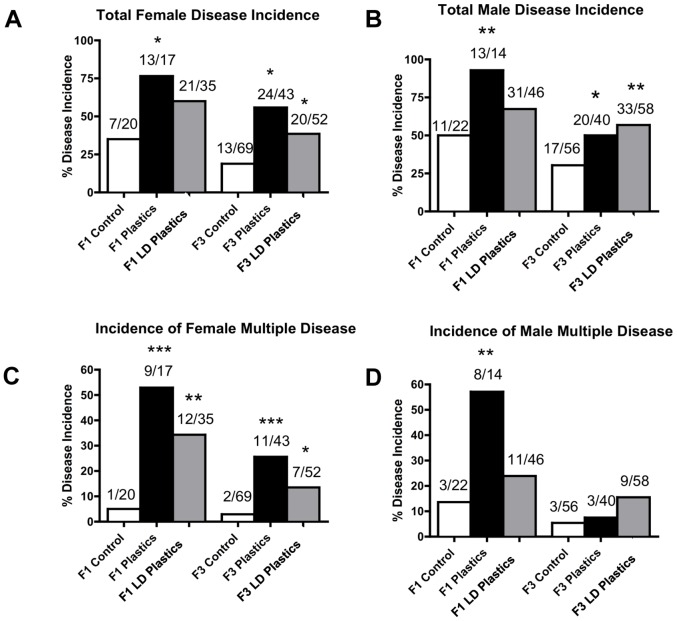
Adult-onset disease/abnormalities in rats from control, plastics, or lower dose(LD) plastics (BPA, DEHP and DBP) lineages. Incidences of total female disease (panel A), total male disease (panel B), female multiple disease (panel C) and male multiple disease (panel D) in F1 and F3 generations are presented. The actual number of diseased rats/total number of rats in each group are shown above the respective bar graphs (* P<0.05; ** P<0.01; *** P<0.001).